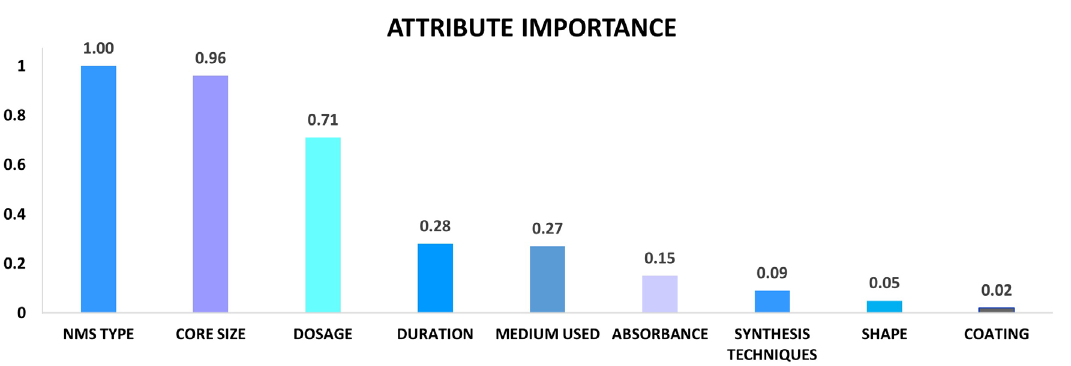
Figure 4. Attribute importance generated by random forest model, y-axis represents the variable importance from 0 to 1, x-axis represents the attributes.